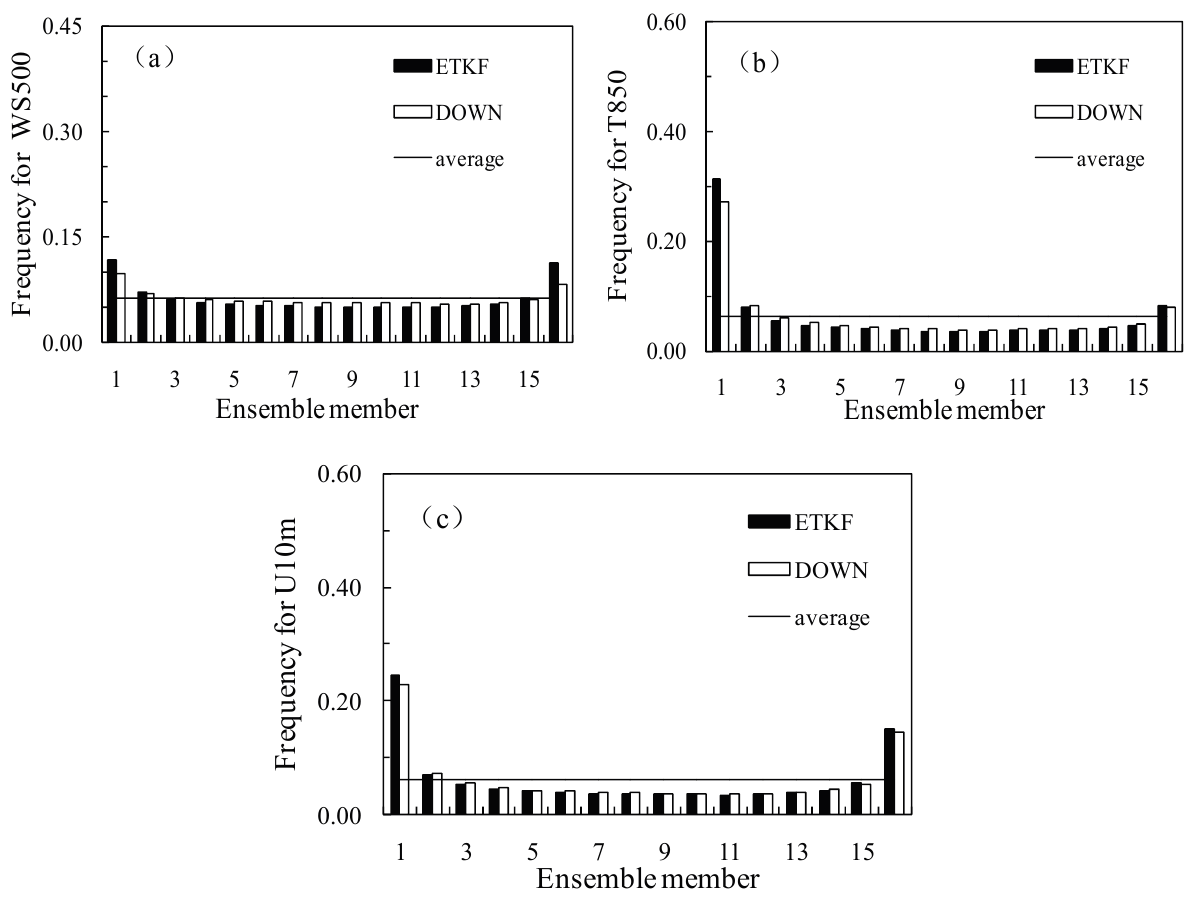
Figure 8. Talagrand for ETKF and DOWN at forecast lead time of 24 h. ( a ) 500 hPa wind speed; ( b ) 850 hPa temperature; ( c )10 m U